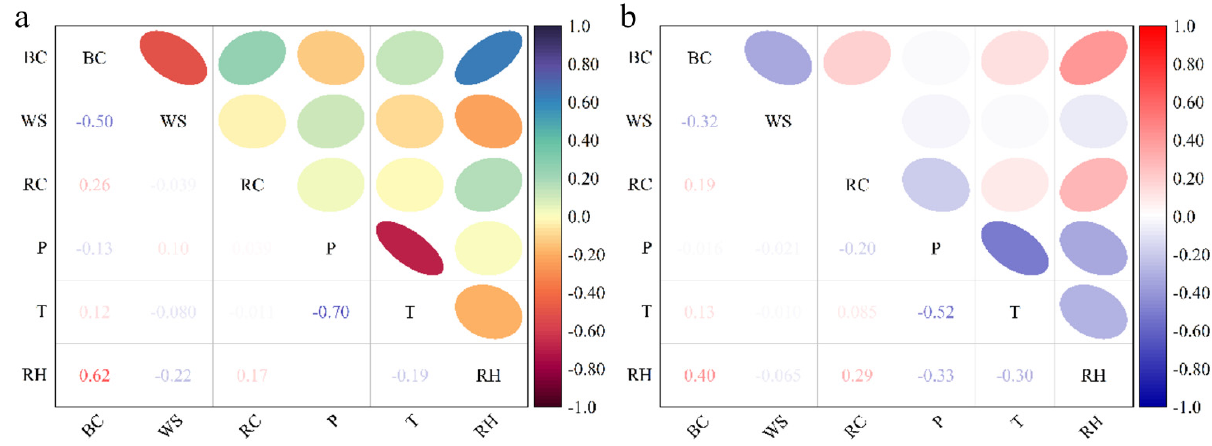
Figure 9. Correlation analysis of wind speed (WS), rainfall capacity (RC), barometric pressure (P), air temperature (T), relative humidity (RH), and BC for the heating and non-heating seasons (( a ): heating season; ( b ): non-heating season).